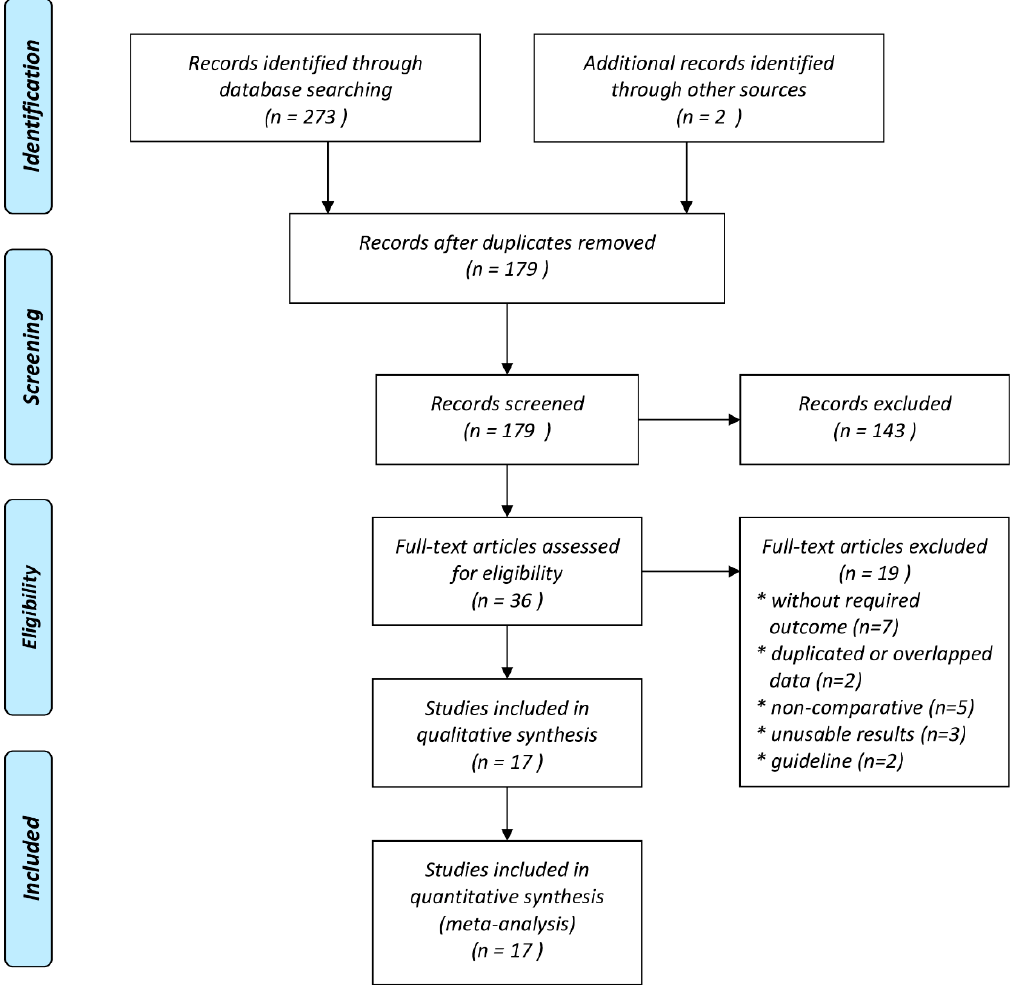
Figure 1. Meta-analysis flow chart of included and excluded studies.